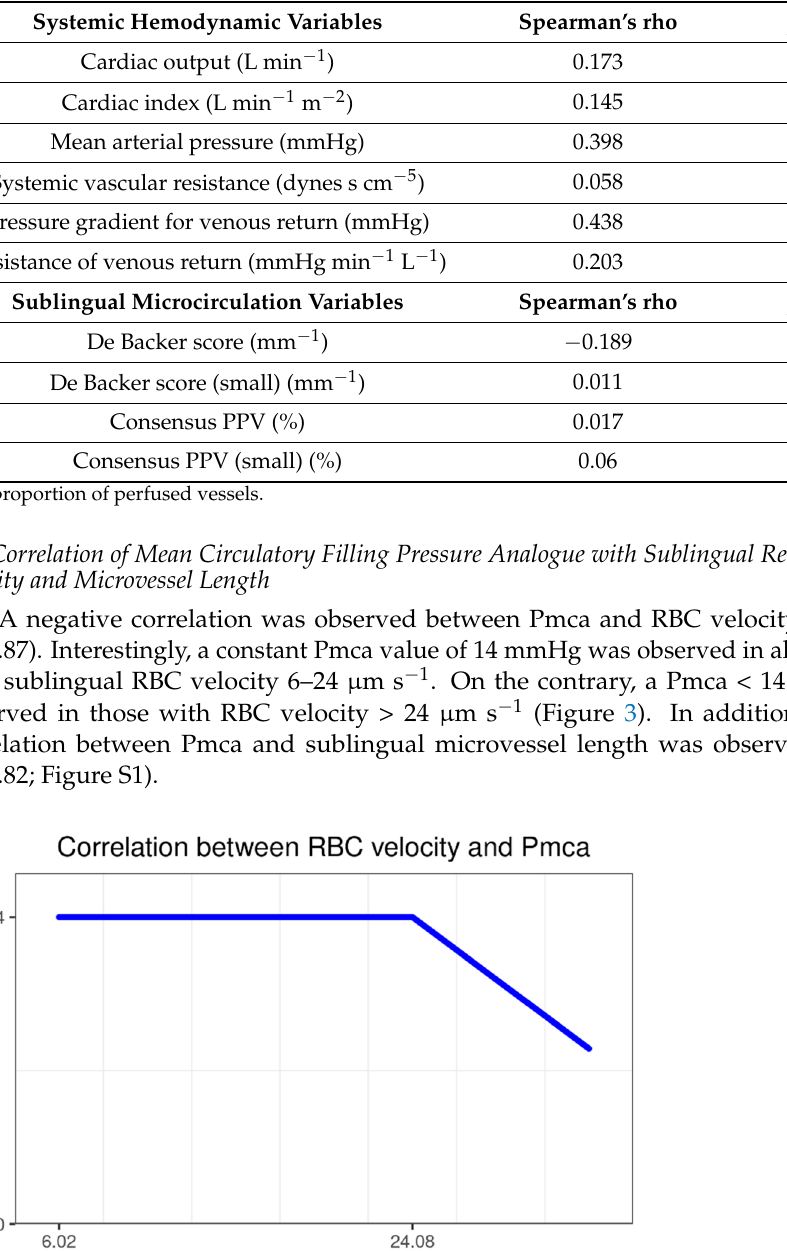
Table 3. Correlation of Pmca with systemic and sublingual microcirculation variables.